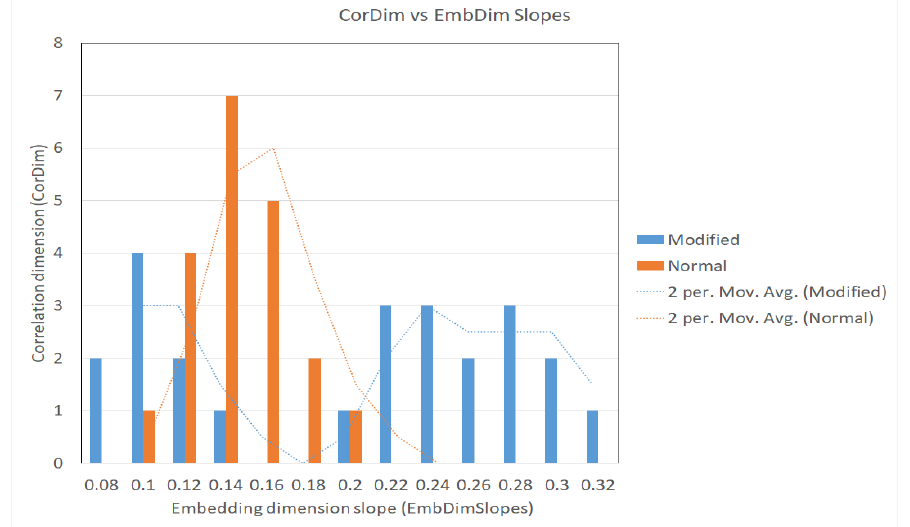
Figure 21. Graphic of the fractal dimension for the unaffected area.